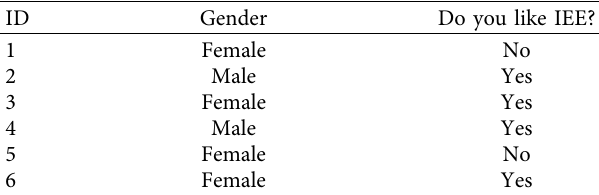
Table 5: Gender attribute list.